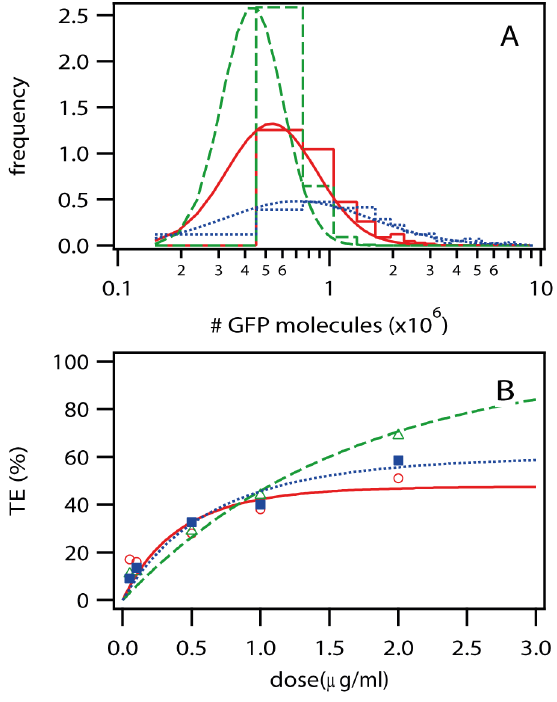
Figure 6. GFP expression (Simulation vs. Experiment based on time courses shown in Figure 4). A) Expression Level. Maximum number of GFP molecules with histograms of the distributions and lognormal fits of the histograms as curves. The dashed green lines are from a simulation of the streamlined model. The solid red lines are from a simulation of the multiple-lipoplex model. The dotted blue lines show the experimental data. B) Dose-Response Relationship. Transfection efficiency (TE) is the percentage of cells that exhibited a successful transfection, based on GFP expression. The curve was determined by varying the dosage ( m g/ml) in the experiment, and the initial concentration of lipoplexes in the simulation (L ex ). The green open triangles are from the simulation of the streamlined model, and the dashed green line is a single-Poissonian fit. The open red circles are from the simulation of the multiple-lipoplex model and the solid red line is a double-Poissonian fit. The solid blue squares are from the experimental data and the dotted blue line is a double-Poissonian fit.